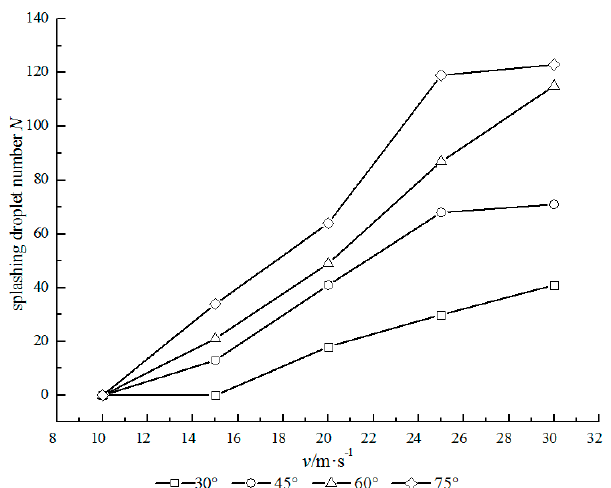
Figure 8. Effect of impact velocity on the number of splashed oil droplets when the oil droplet diameter is 300 μ m.